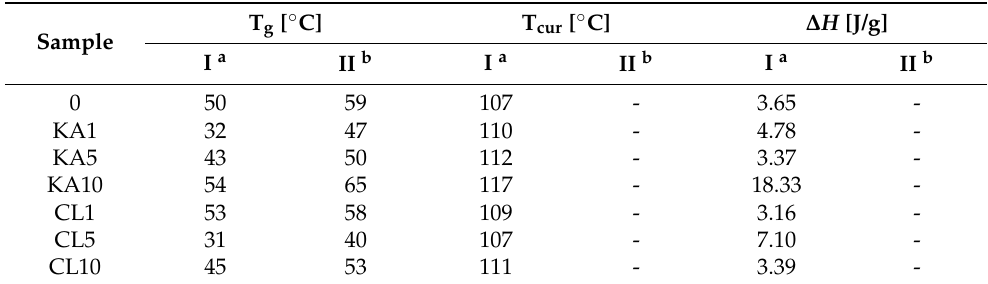
Table 2. DSC data of the prepared